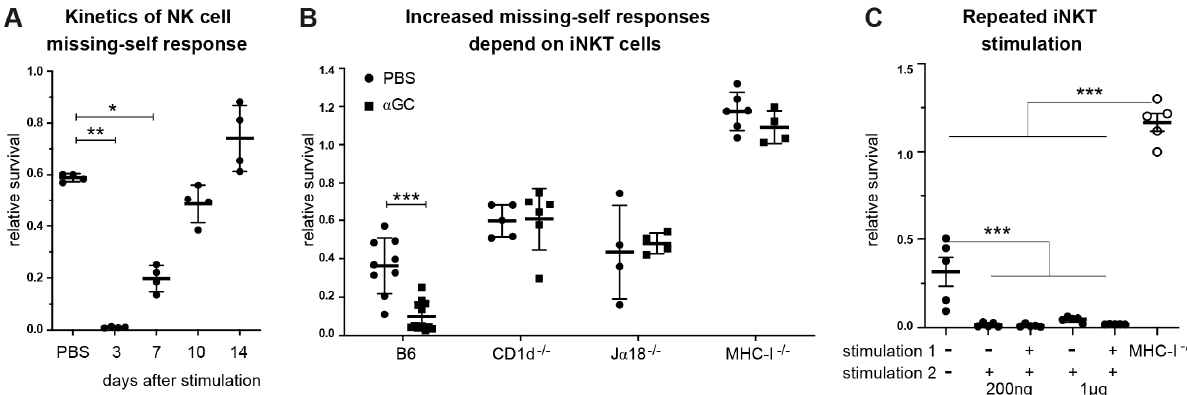
Figure 6. Increased missing self-responses after α GC-treatment. Mice were injected i.v. with PBS, or α GC. 3 to 14 days after in vivo stimulation, survival of target cells was tested by challenging the mice with a mix of CFSE-labeled B6 and β 2 m − / − spleen cells. Remaining target cells were measured by flow cytometry. The survival ratio of remaining MHC-I − ( β 2 m − / − ) target cells is shown, divided by remaining MHC-I + (B6) control cells (relative survival). ( A ) Rejection capacity of NK cells with α GC. ( B ) Missing self-responses of C57Bl/6, MHC-I − / − , CD1d − / − or J α 18 were assessed at day 7 after in vivo α